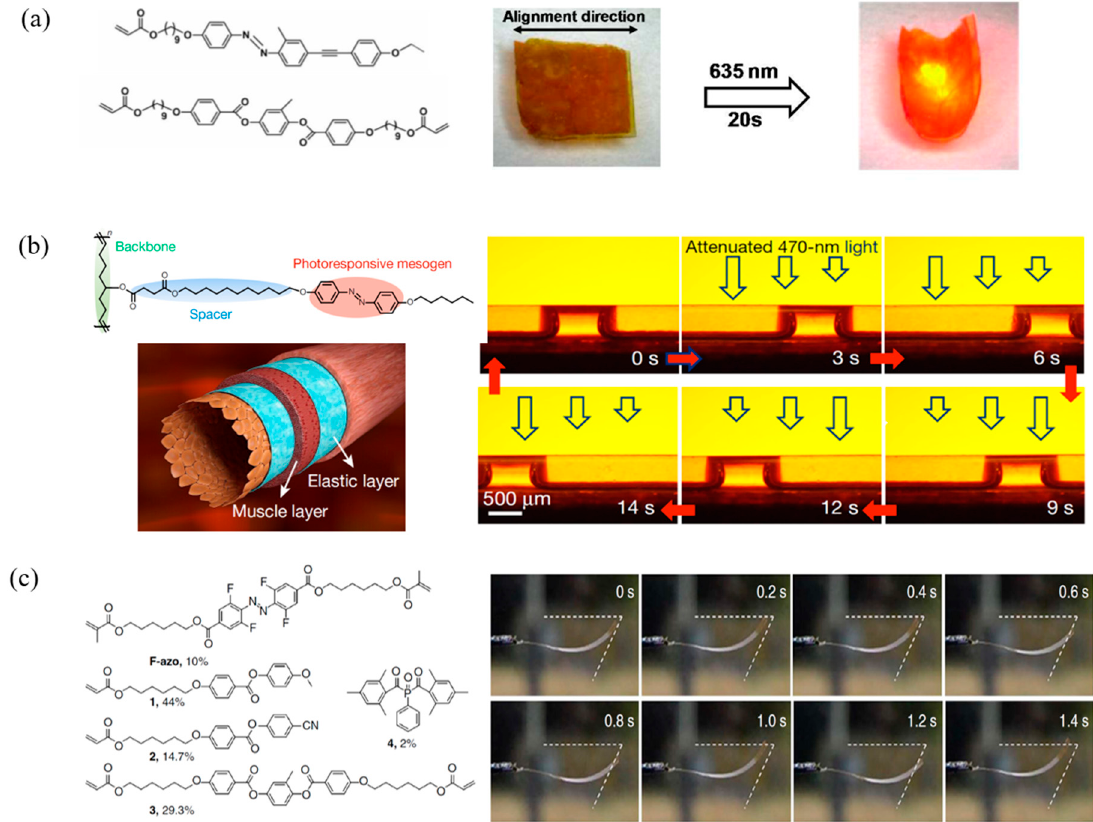
Figure 7. Photo responsive LCPs based on trans–cis photoisomerization of azobenzene irradiation by NIR light. ( a ) Chemical structures of LC monomers and the photographs of the as-prepared assembly film bending toward the 635 nm laser. Reprinted with permission from [82]. Copyright (2006) American Chemical Society. ( b ) Schematic illustration of the structure of artery walls of tubular micro-actuator, (left)). Manipulation of fluid propulsion by photo-induced tubular micro-actuators, (right). Reprinted with permission from [83]. Copyright 2016 Nature Publishing Group. ( c ) Chemical structures of ortho-fluoroazobenzene mesogens and schematic of the LC splay aligned azobenzene-containing film (left). Series of snapshots depict self-oscillatory motion of the film during sun exposure (right). Reproduced under the terms of the CC BY 4.0 license [78]. Copyright 2016, The Authors, published by Springer Nature.